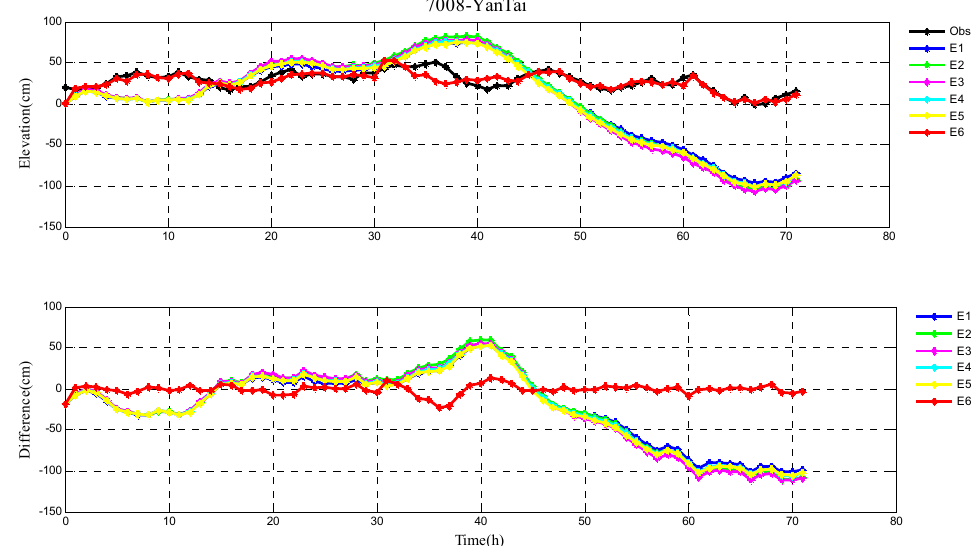
Figure 6. Storm surge elevations in six experiments (E1–E6), observations (black line) ( top ), and the differences between them ( bottom ) during Typhoon 7008 at LongKou station.